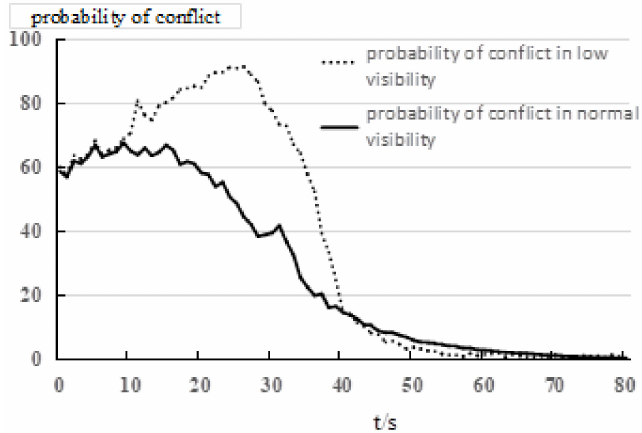
Figure 16. Conflict Probability under Different